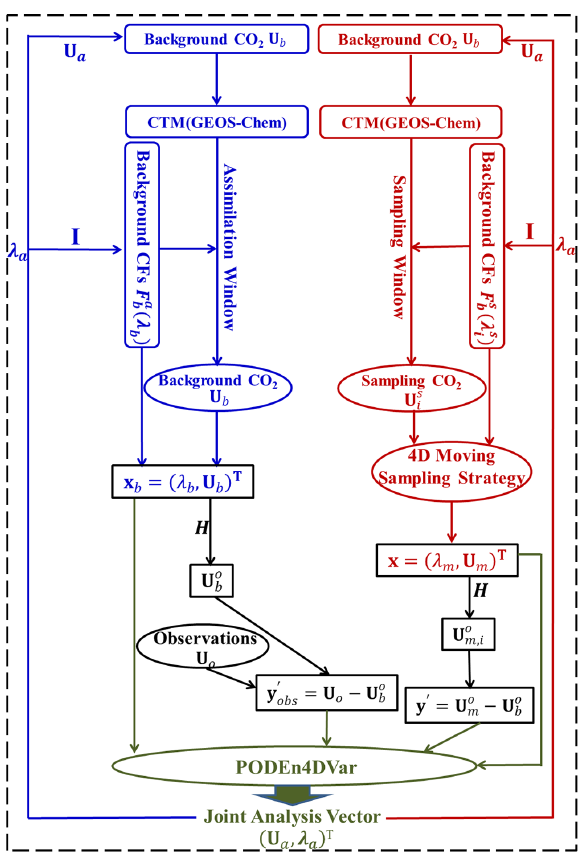
Figure 1. Flowchart of the Tan-Tracker joint data assimilation sys- tem.